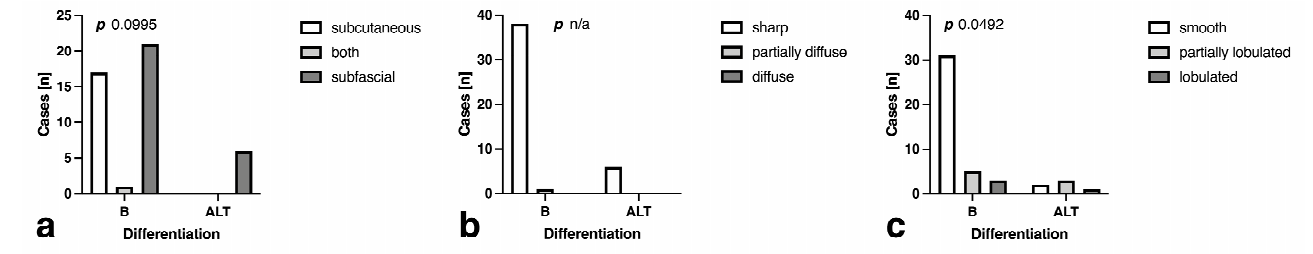
Figure 2. Bar plots demonstrating the distribution of ( a ) localization, ( b ) border definition and ( c ) border contour for benign (B) tumors and atypical lipomatous tumors (ALT). Cases with atypical septation morphology (thickening, nodularity) were more likely to be ALT ( p = 0.002, Figure 3a), and this was mirrored by a significantly higher maximum septation thickness in ALT (3.25 ± 2.65 mm vs. 0.80 ± 0.45 mm, p < 0.0001) (Figure 3b).